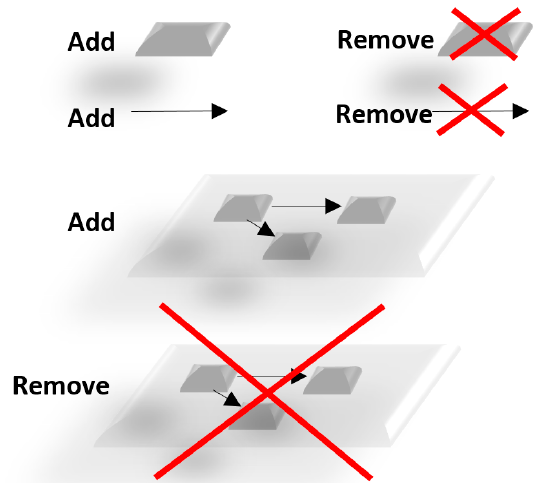
Figure 3. Standard Operations in mully .